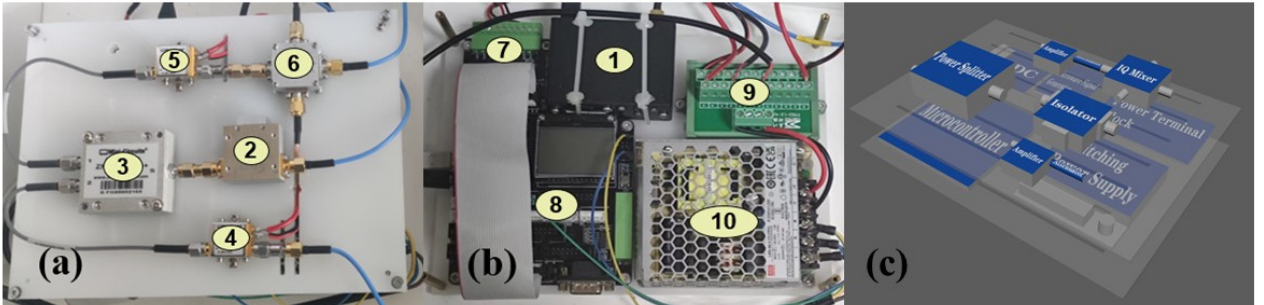
Figure 3. Circuit module: ( a ) high-frequency microwave circuit module; ( b ) low-frequency circuit power module; ( c ) 3D simulation of the whole module; ① . Microwave signal generator; ② . Isolator; ③ . Power splitter; ④ . Low-noise amplifier 2; ⑤ . Low-noise amplifier 1; ⑥ . IQ mixer; ⑦ . AD converter; ⑧ . Microcontroller; ⑨ . Power terminal block; ⑩ . Switching power supply.